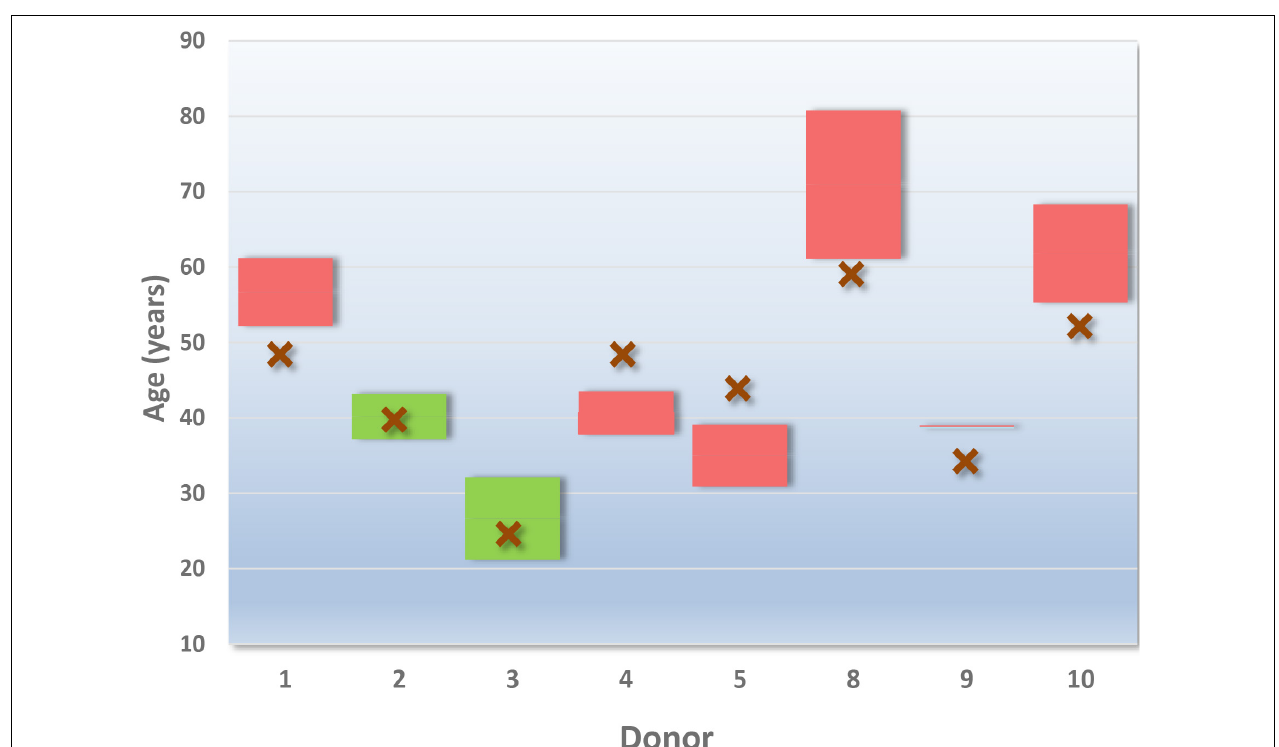
FIGURE 1 | Provider A age predictions for 8 of the 10 donors. The declared age of the donor is indicated by an “X” (red). The boxes outline the predicted age range given by the service provider (reported by the provider as a “95% confidence interval”). Green boxes encompass a correct prediction. Red boxes indicate an incorrect prediction for the